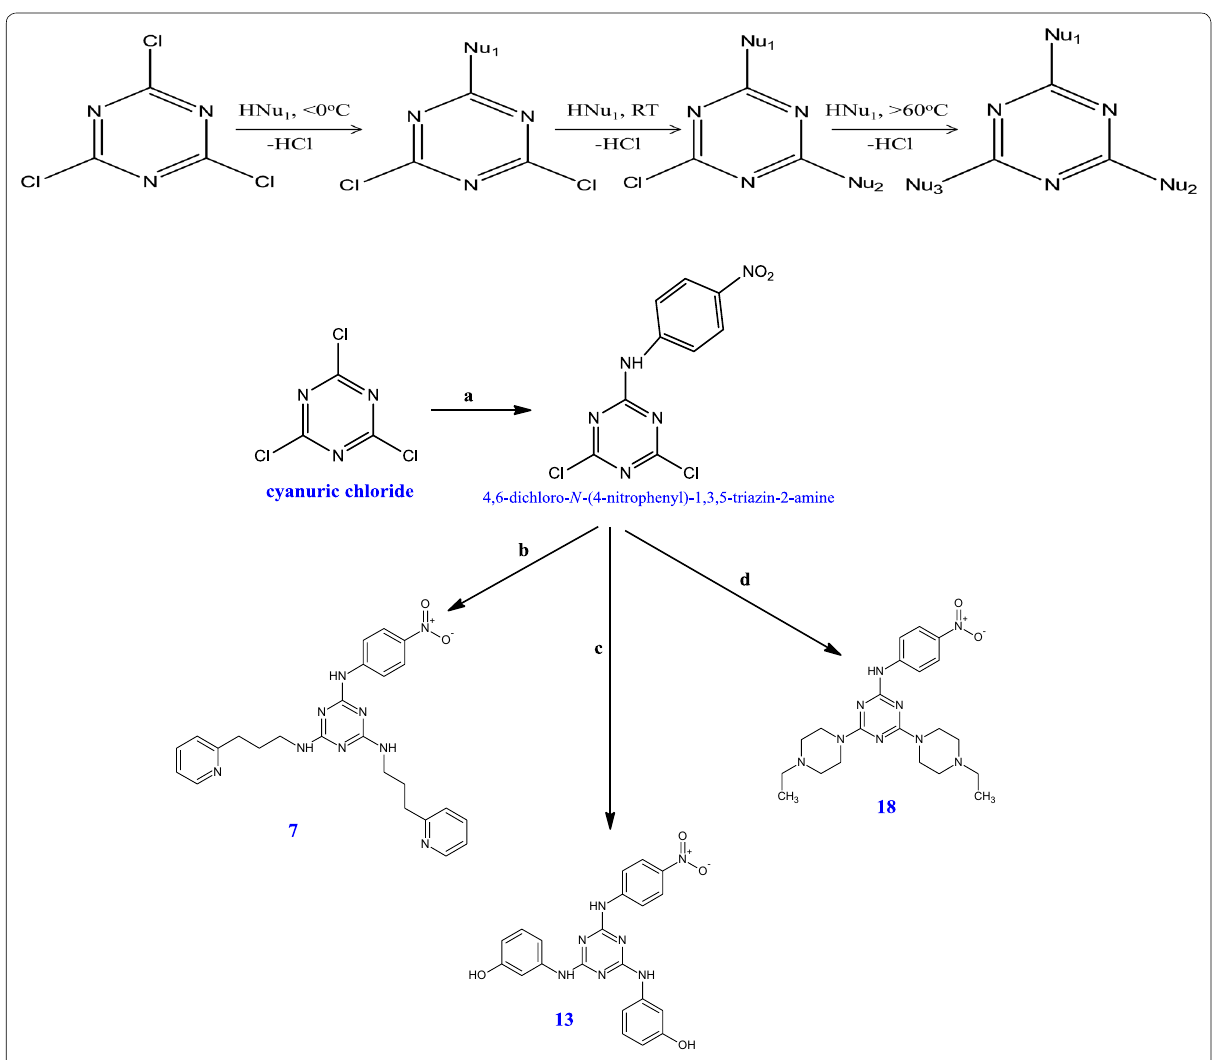
Scheme 1 Scheme for the synthesis of 1,3,5-triazine ( s -triazine) derivatives ( 7 , 13 and 18 ). Regents: (a) p -nitroaniline, K 2 CO 3 in THF, (b) 1-chloro- 4-ethylpiperazine,